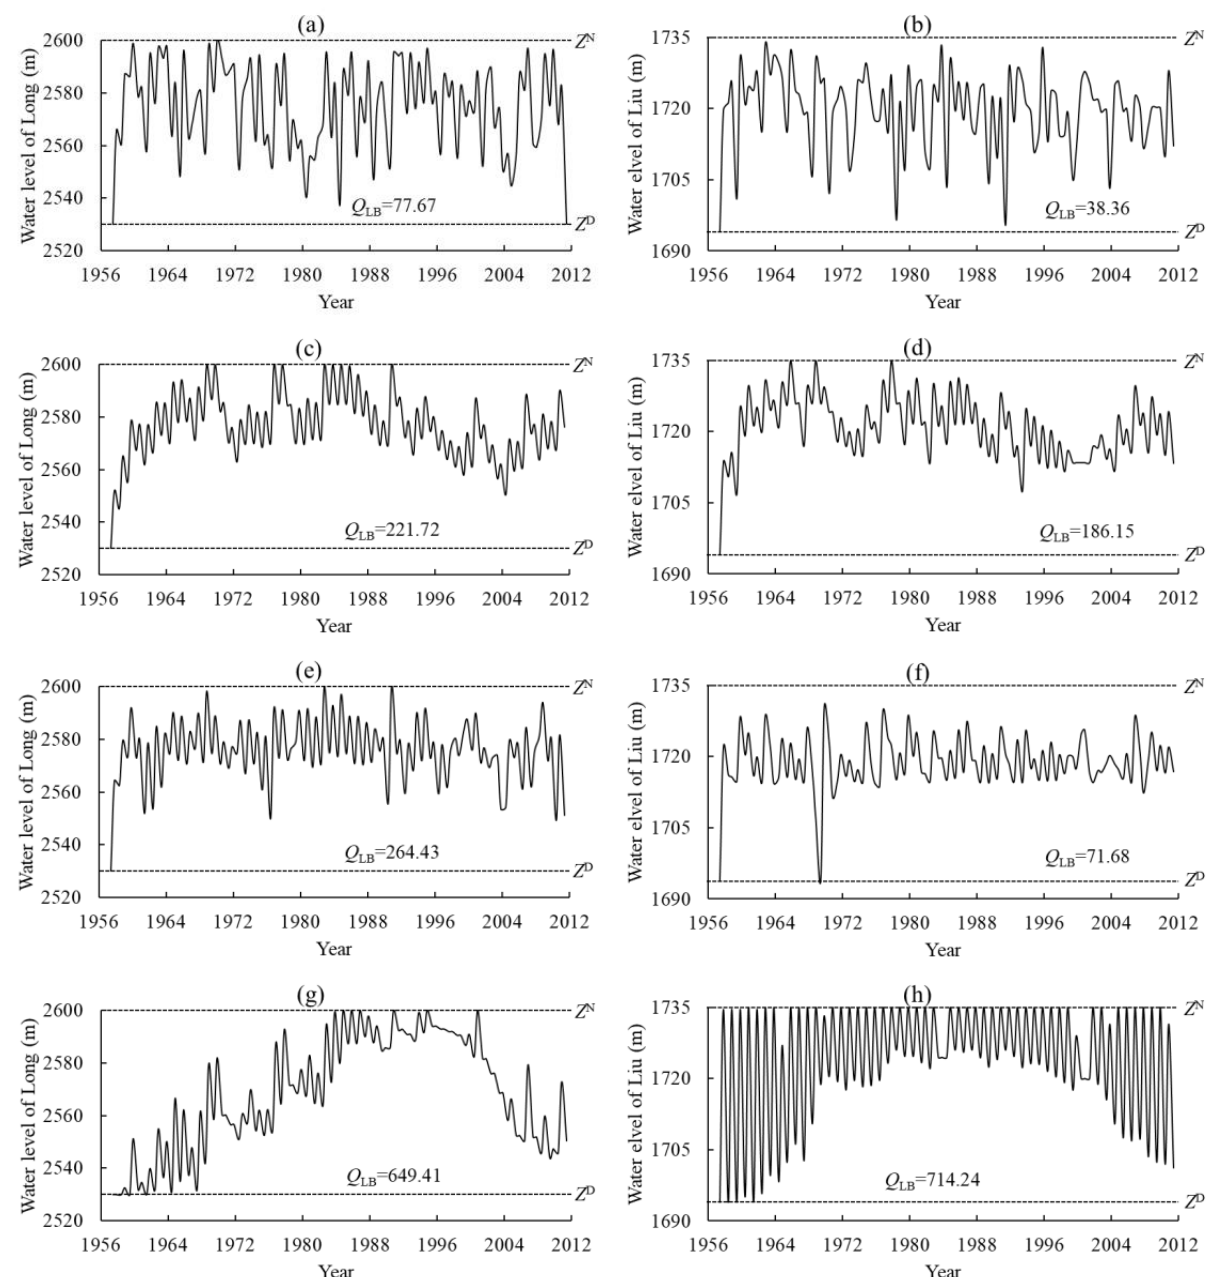
Figure 7. The OPT approach-based ( a , b ), MLR rules-based ( c , d ), ANN rules-based ( e , f ), and TPR rules-based ( g , h ) water-level processes (Note: ( a , c , e , g ) show the water level processes of Long reservoir, and ( b , d , f , h ) display the water-level processes of Liu reservoir).